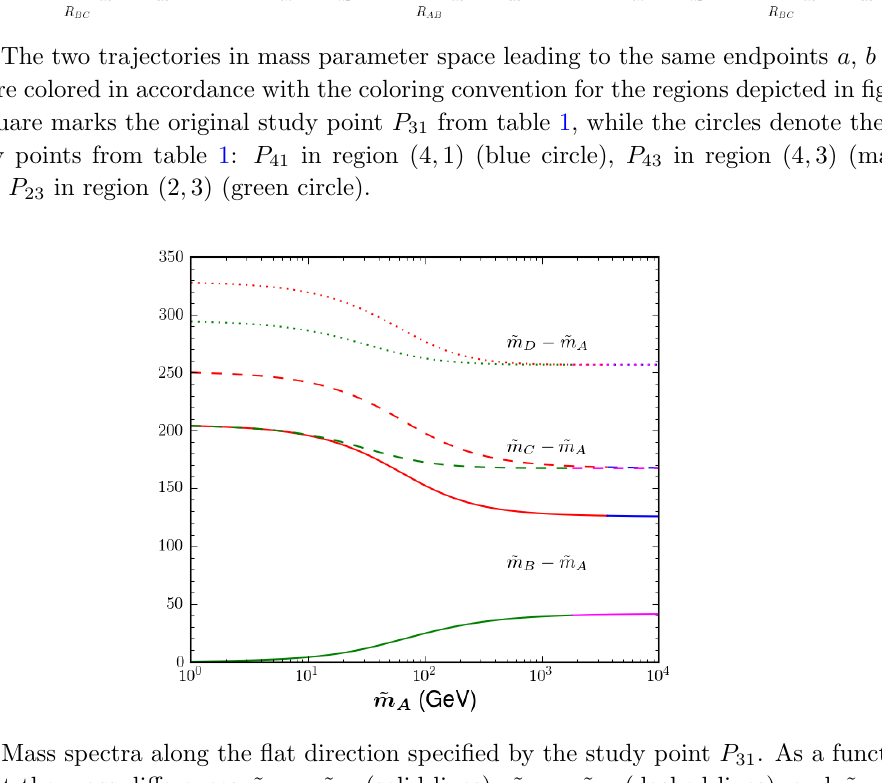
31 . As a function of ~ m A (solid lines), ~ m C ~ m A (dashed lines), and ~ m D ~ m A (cid:0) (cid:0) (cid:0)